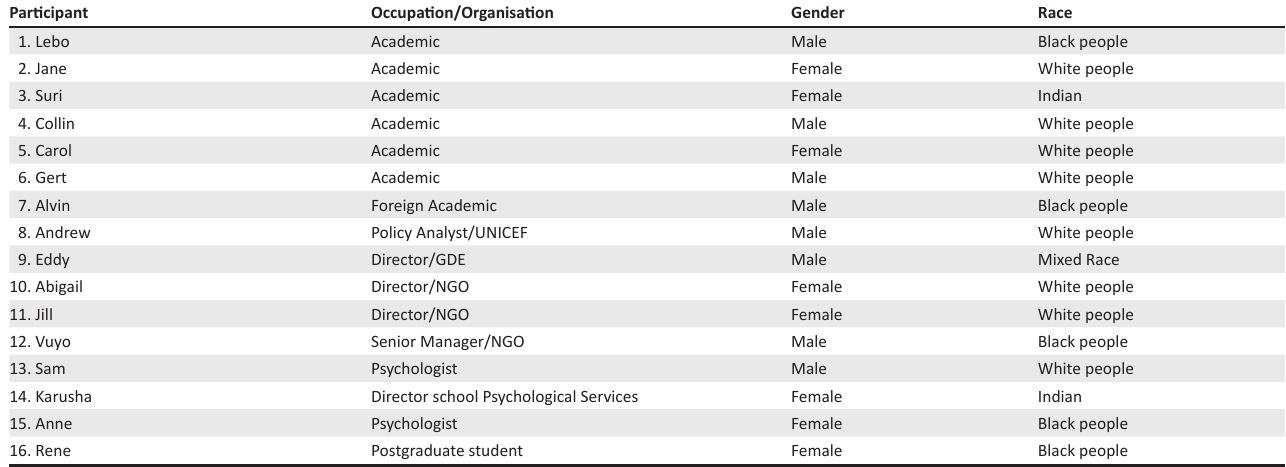
TABLE 1: Profile of participants.